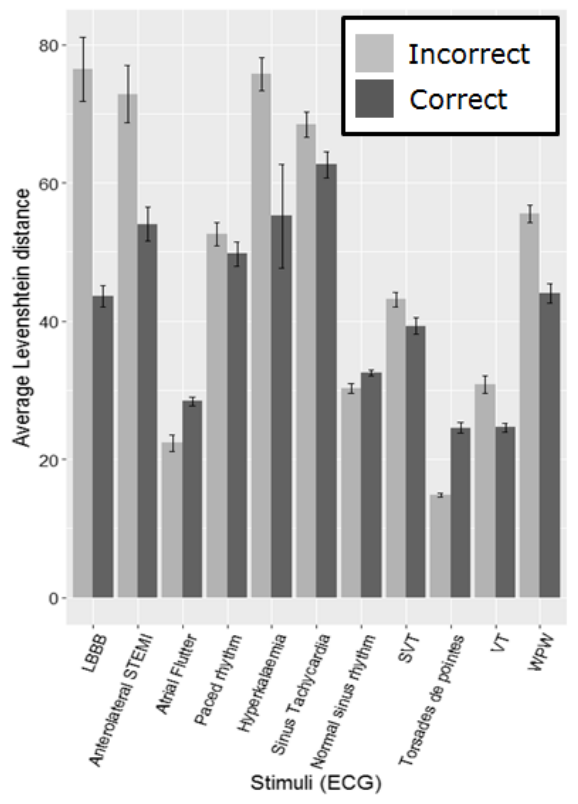
Figure 4: The average Levenshtein distance for both groups for each ECG (errorbars represent the SE) Figure 4 shows the average Levenshtein distance per group for each ECG. As the number of participants mak-